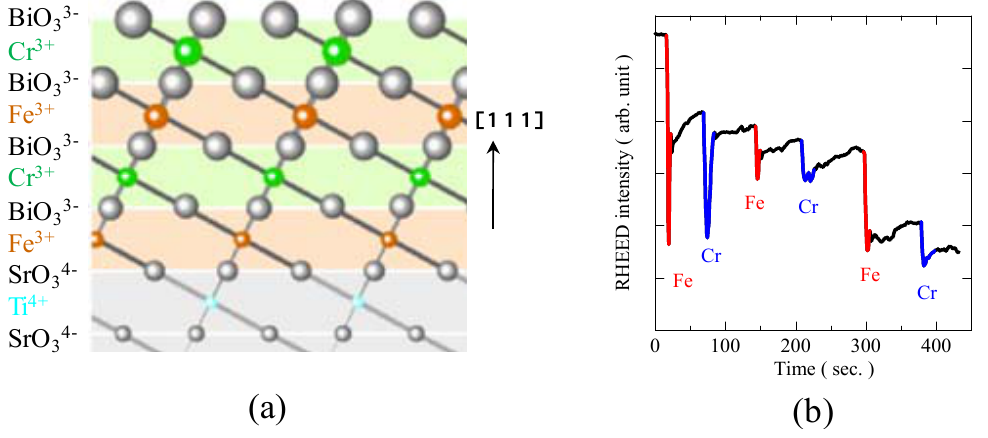
Figure 9. (a) Schematic figure of BiFeO (1 1 1) substrate. Monolayers of BiFeO respectively. One-by-one stacking of the BiFeO direction produces the rock-salt configuration of Bi 3+ and Cr 3+ ions in the perovskite structure, so the Fe 3+ -O-Cr 3+ magnetic path is expected to lead to the ferromagnetism; (b) RHEED intensity oscillation during the deposition of the 6-monolayer artificial superlattice thin film, confirming the two-dimensional layer-by-layer